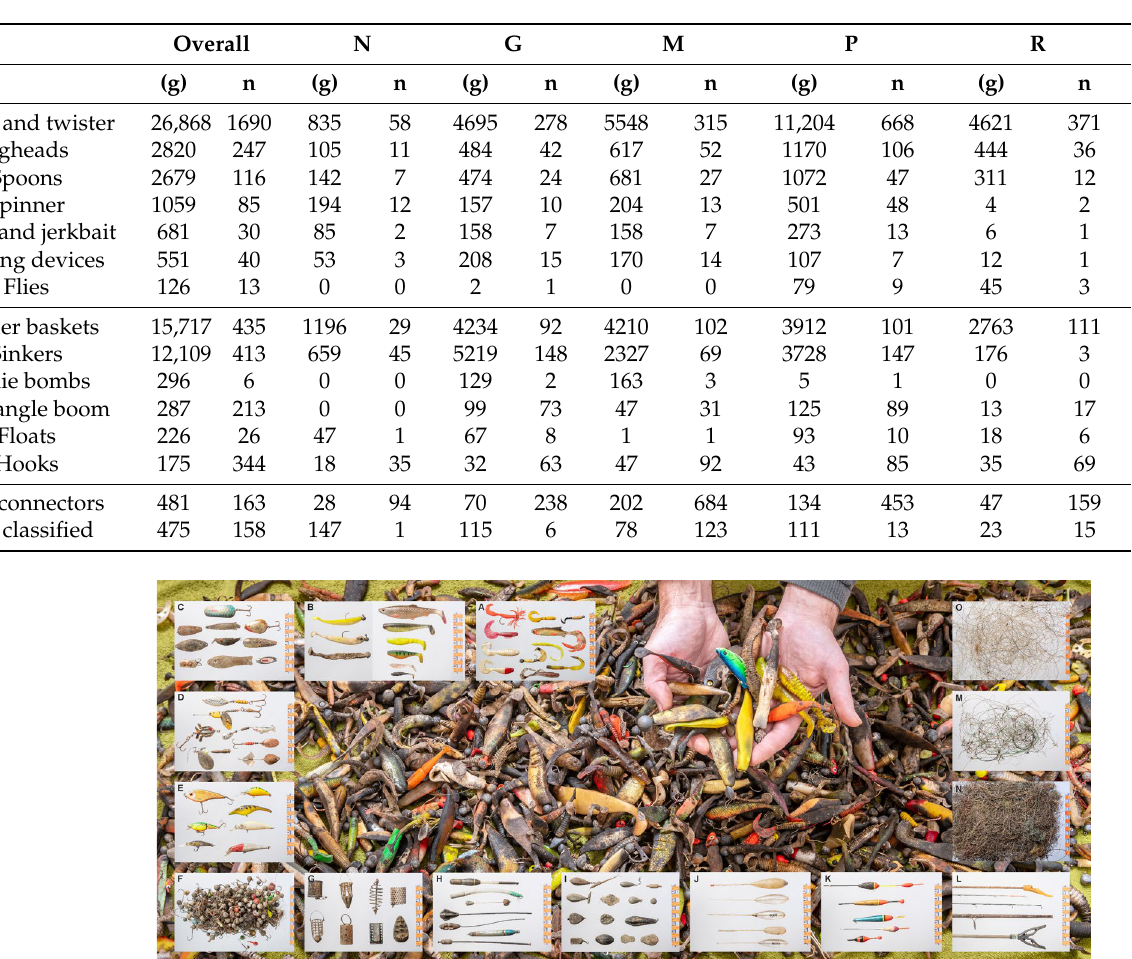
Table 1. Classification of lost fishing tackle found in Lake Eixendorf attributed to active and passive fishing methods or not being attributed (N.A.). Items are displayed in Figure 2. Overall = weight (g) of items (n) for the respective item class, condition of items is attributed to N = new, G = good, M = medium, P = poor, or R = rotten.